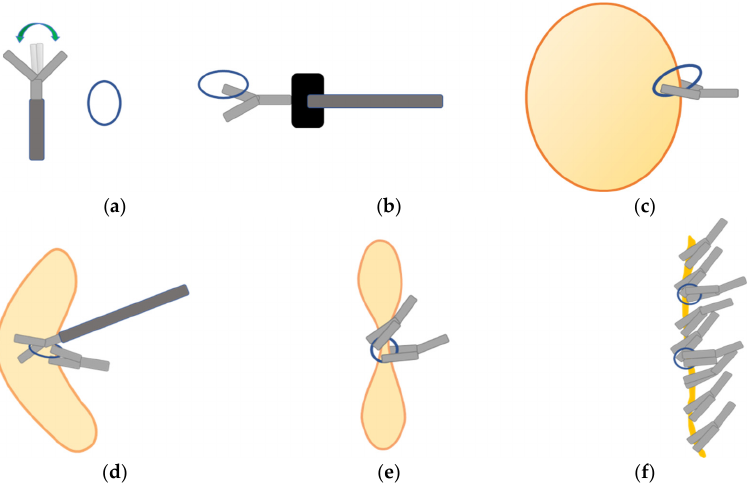
Figure 1. ( a ) An open–close clip (SureClip) and loop were prepared. ( b ) After removal of the forceps plug from the endoscope, the SureClip was passed through the forceps plug and then opened to grasp the loop. ( c ) The forceps plug was reattached to the endoscope, and the clip was advanced with the loop to bring it to the edge of the post-ESD mucosal defect. The first clip with a loop grasped proximal to the center of the mucosal defect. ( d ) The next clip was used to drag the loop and grasp the distal side of the mucosal defect. ( e ) After placing the second clip, we can reach the closer bilateral mucosa. ( f ) After the addition of the second clip, both edges of the mucosal defect were adjacent, allowing the addition of SureClips or conventional clips to close the mucosal defect completely. If the bilateral edges of the defect were still at considerable distance, the same process of using a loop and clip was carried out to bring the edges of the defect closer. The procedure was completed once the mucosal defects were completely closed. ( a ) ( f ) Figure 2. ( a ) A gastric angle mucosal defect occurred subsequent to endoscopic submucosal dissection. ( b ) SureClip with the loop is delivered to the mucosal defect. ( c ) SureClip with the loop is clipped to the anal side of the mucosal defect. ( d ) Another clip is placed and used to drag the loop to the oral side of the mucosal defect. ( e ) Both edges of the mucosal defect are observed to be adjacent. ( f ) Clips are added for complete and adequate closure of the mucosal defect.